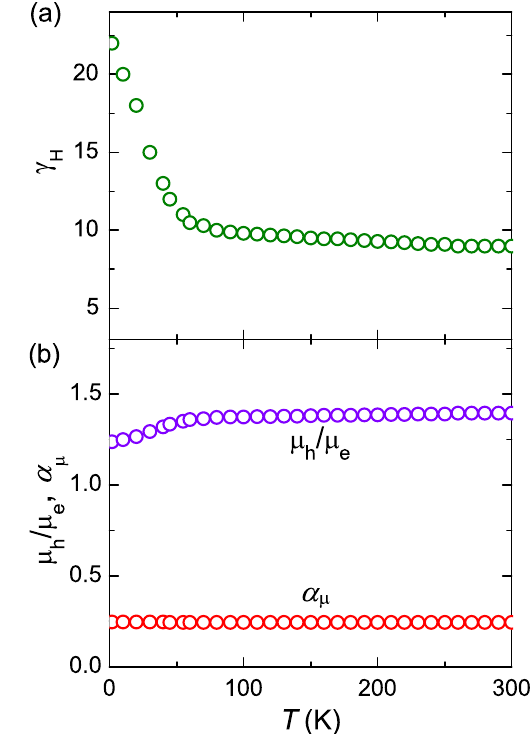
FIG. 5. Parameters derived from scaling magnetoresistances in Fig. 4(b) using Eq. (4). (a) Temperature dependence of γ obtained at low magnetic fields from the plot of MR ∼ ð ρ (b) The ratio μ MR ¼ α μ =e 2 ½ H= ð n ρ 0 Þ(cid:2) 2 at various temperatures, where μ calculated from Eq. (5) using the γ obtained using α μ ¼ ð μ